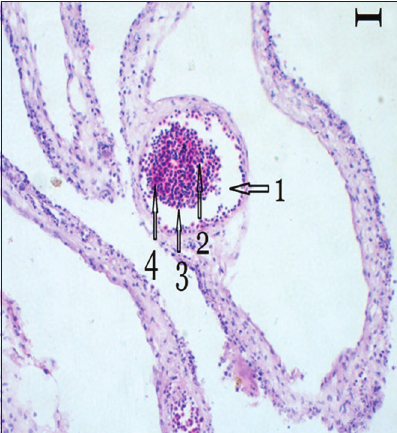
Figure-2: Chorioallantoic membrane histopathology shows infiltration of mononuclear cells (arrow head 2 and 3) and heterofils (arrow head 4) with round inflammatory zones (arrow head 1) (H and E, 200× µm).